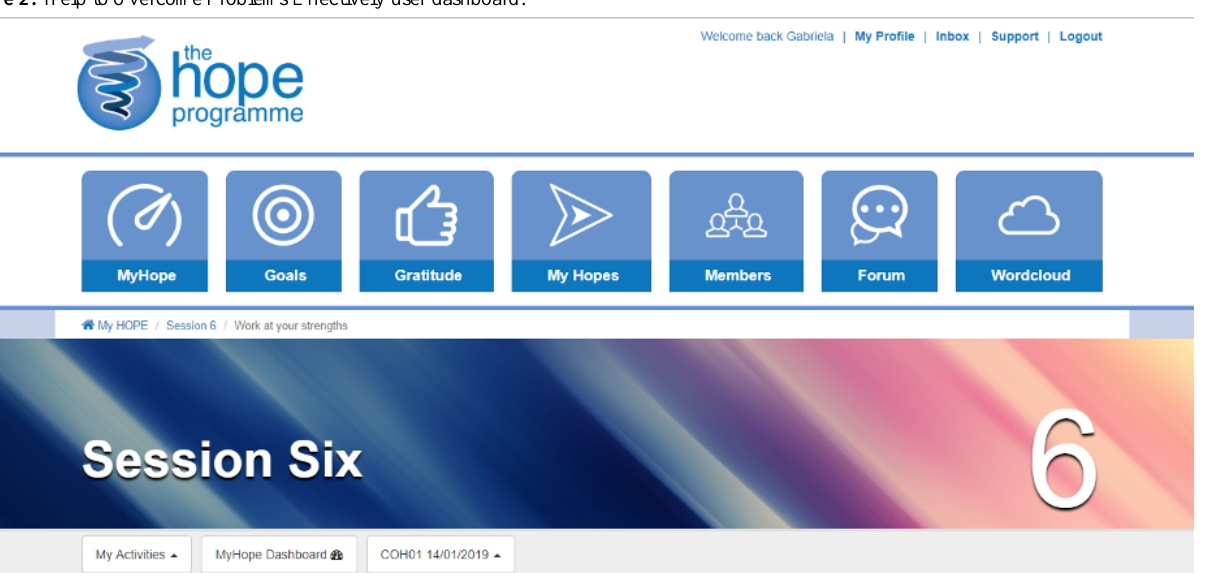
Figure 2. Help to Overcome Problems Effectively user